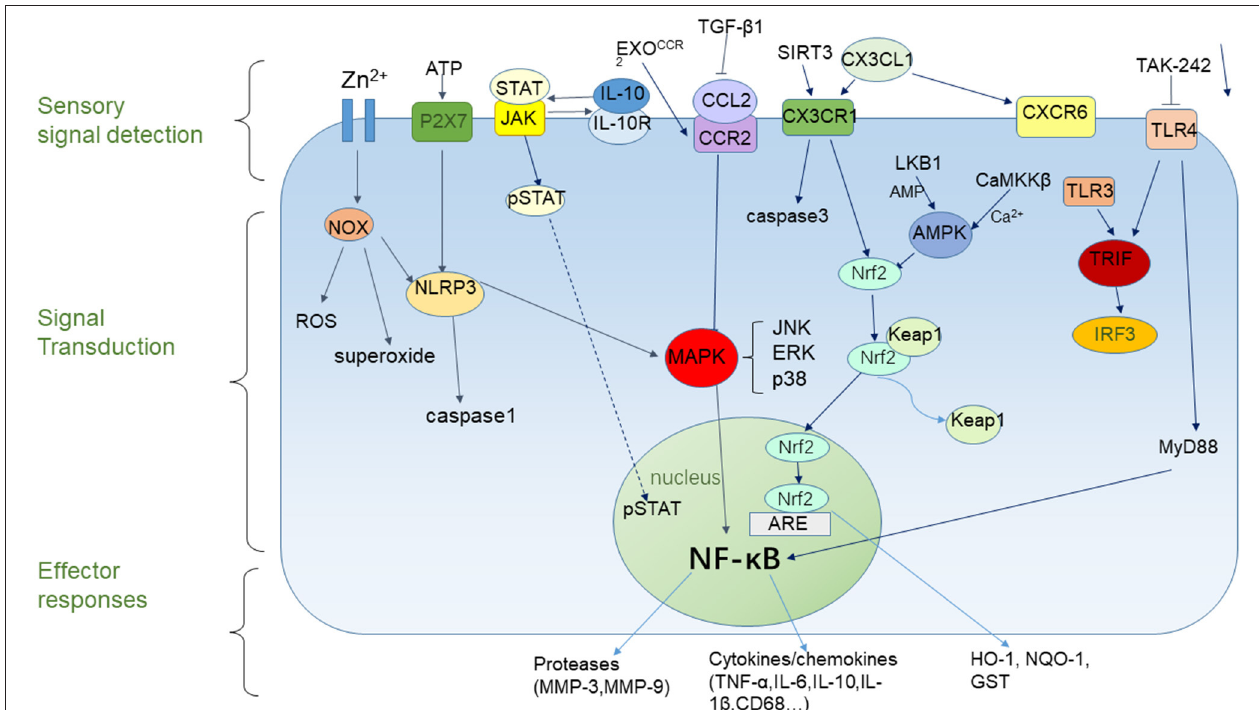
FIGURE 1 | Microglial responses to cerebral ischemia. Microglial responses to cerebral ischemia can be divided into three parts. The sensory component can detect extracellular signals, the signal transduction component can influence gene expression, and the effector component can active pro-inflammatory or anti- inflammatory